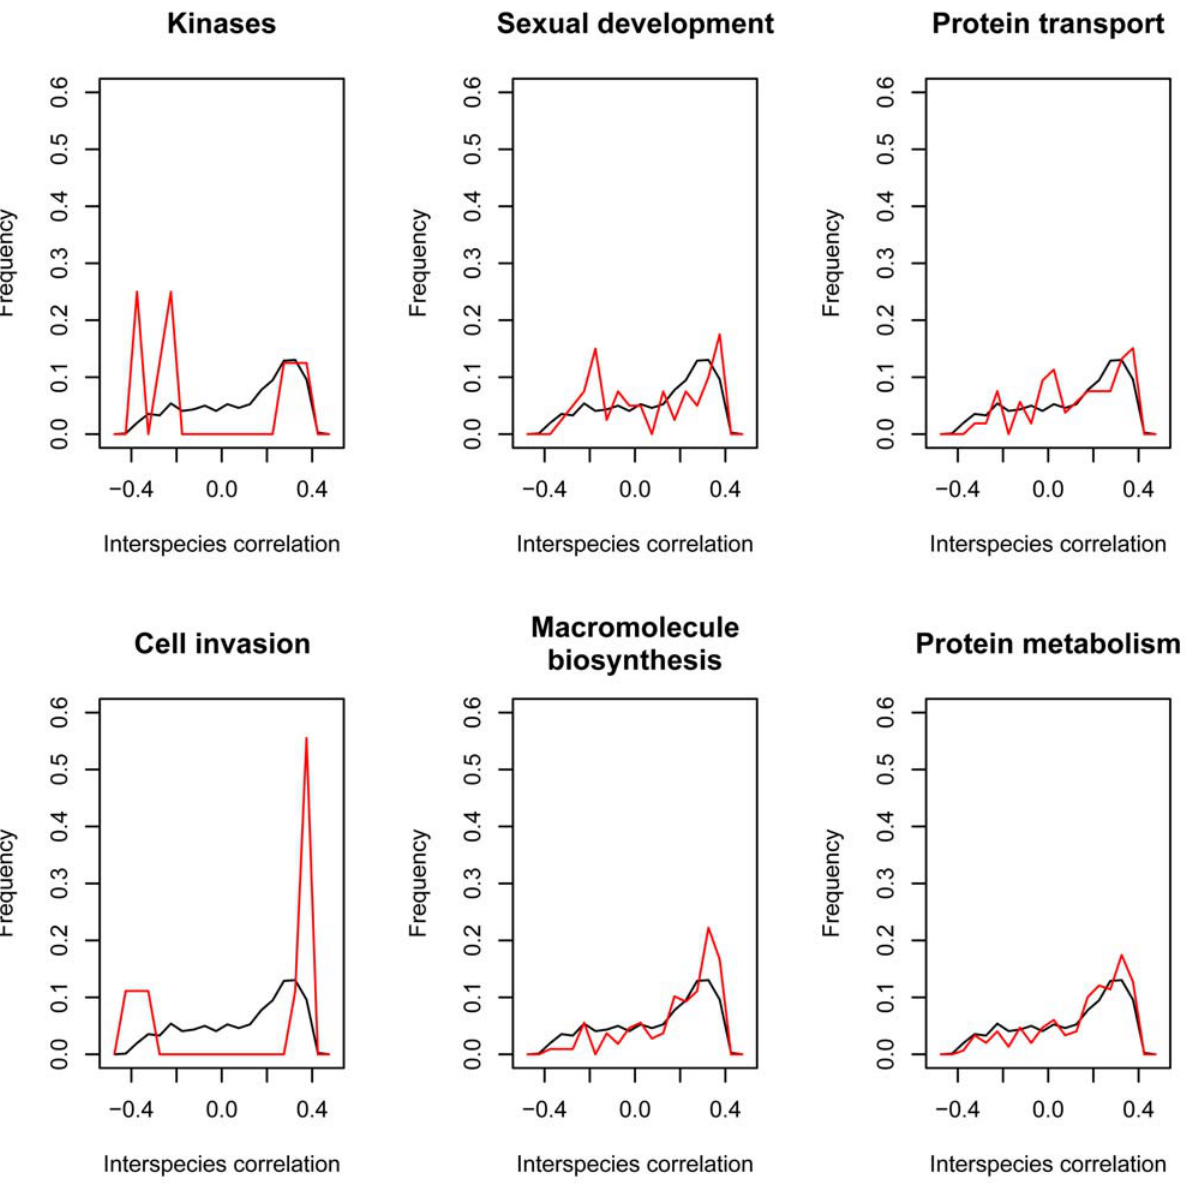
Figure 8. Distributions of interspecies correlation coefficients for 6 groups of genes. The distribution for each group is in red and that of all genes for which we have expression is shown in black (n=760). Kinases (n=9), sexual development (n=41), protein transport (n=54), cell invasion (n=10), macromolecule biosynthesis (n=109), protein metabolism (n=150).